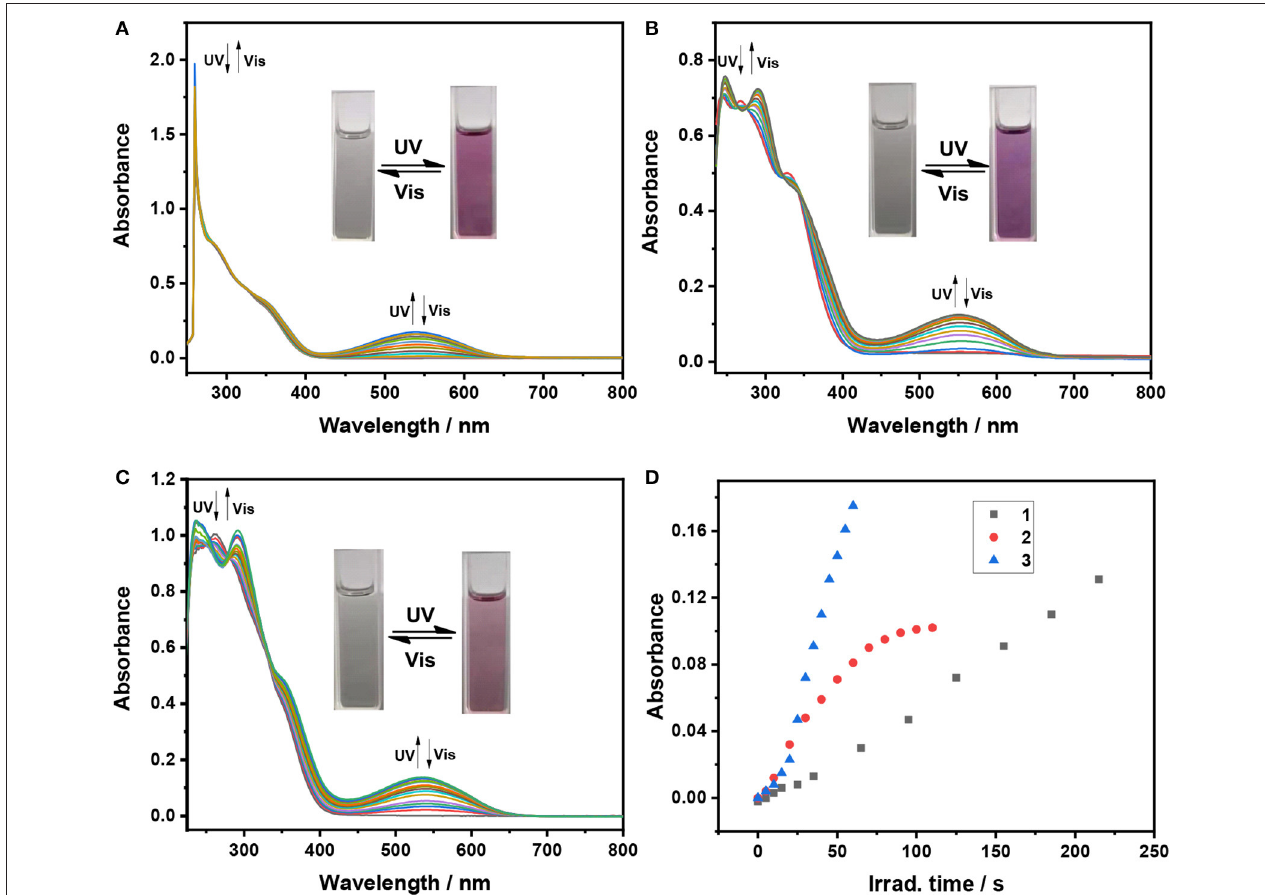
FIGURE 1 | Absorption spectral changes of dithienylethenes 1–3 with 254nm UV and > 402nm Vis light irradiation in THF (2 × 10 − 5 mol/L), (A) spectral changes for 1 (0–395s for cyclization, irradiation interval: 5s; 0–650s for cycloreversion, irradiation interval: 10s); (B) spectral changes for 2 (0–110s for cyclization, irradiation interval: 5s; 0–195s for cycloreversion, irradiation interval: 10s); (C) spectral changes for 3 (0–85s for cyclization, irradiation interval: 5s; 0–125s for cycloreversion, irradiation interval: 10s); (D) the optical response rate monitored at the maximum absorption wavelength in the visible region for ring-closed isomers 1c – 3c .